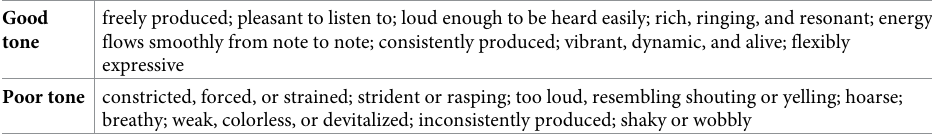
Table 7. Good and poor tone (McKinney, 2005